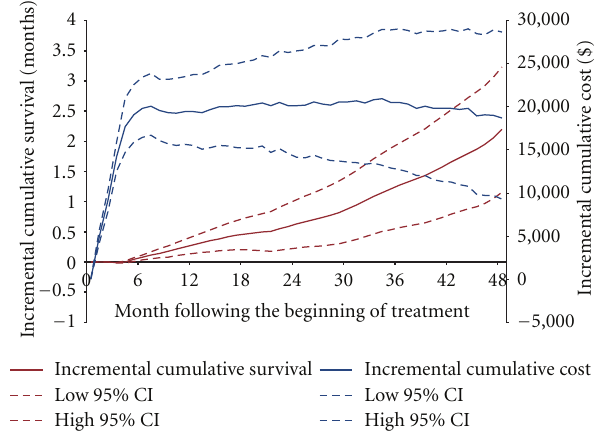
Figure 3: Incremental cumulative survival and total cost of adding rituximab to